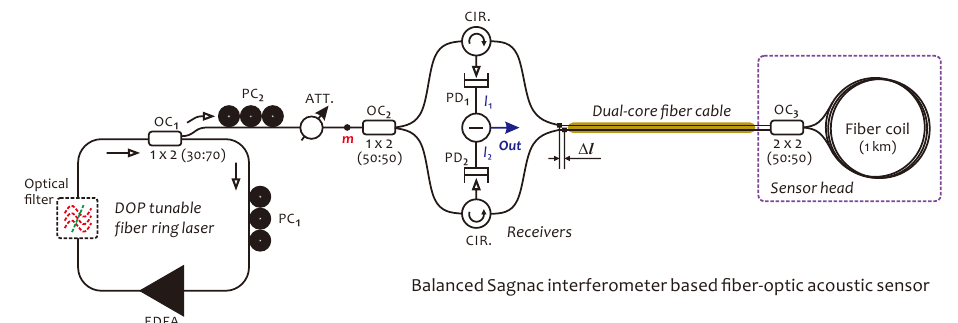
Figure 4. Schematic of the proposed sensor configuration. In this configuration, PC CIR., ATT., and PD represent the fiber polarization controller, the fiber coupler, the optical i circulator, the optical attenuator, as well as photodetector, respectively. ∆ l is the length difference between two transmission fibers in dual-core fiber cable. EDFA, erbium-doped fiber amplifier.